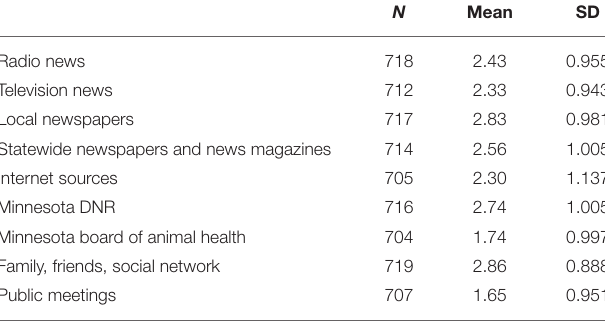
TABLE 4 | Sources of